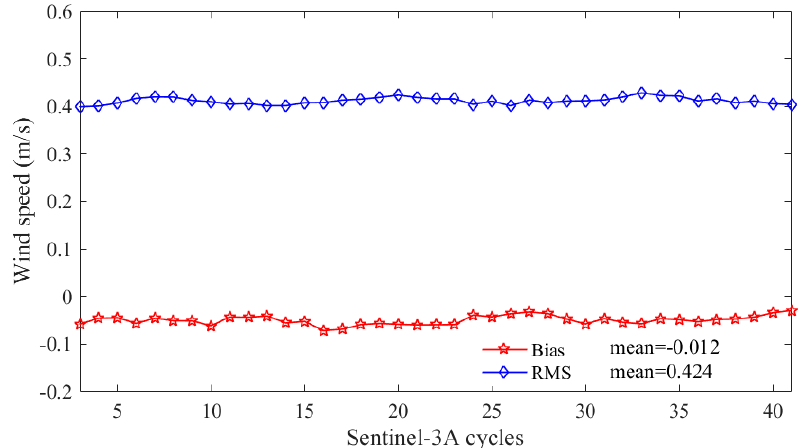
Figure 15. Cycle by cycle biases and RMSEs of wind speed differences between SAR and PLRM mode.